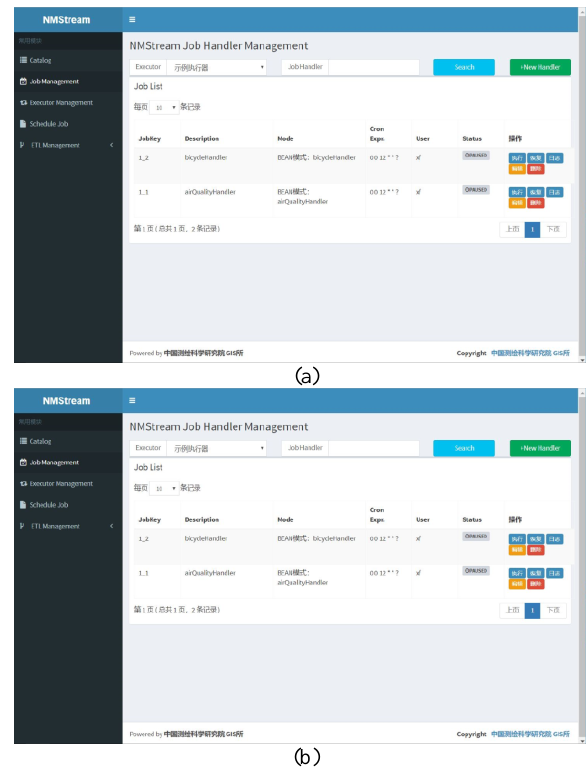
Figure 6: User interface of NMSream